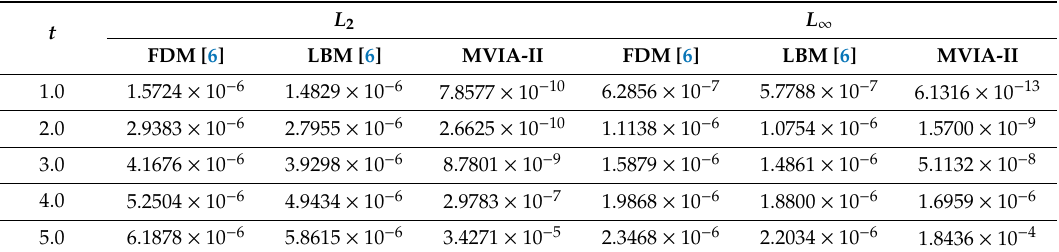
Table 4. Comparison of error norms di ff erent values of t and x for Test Problem 2.